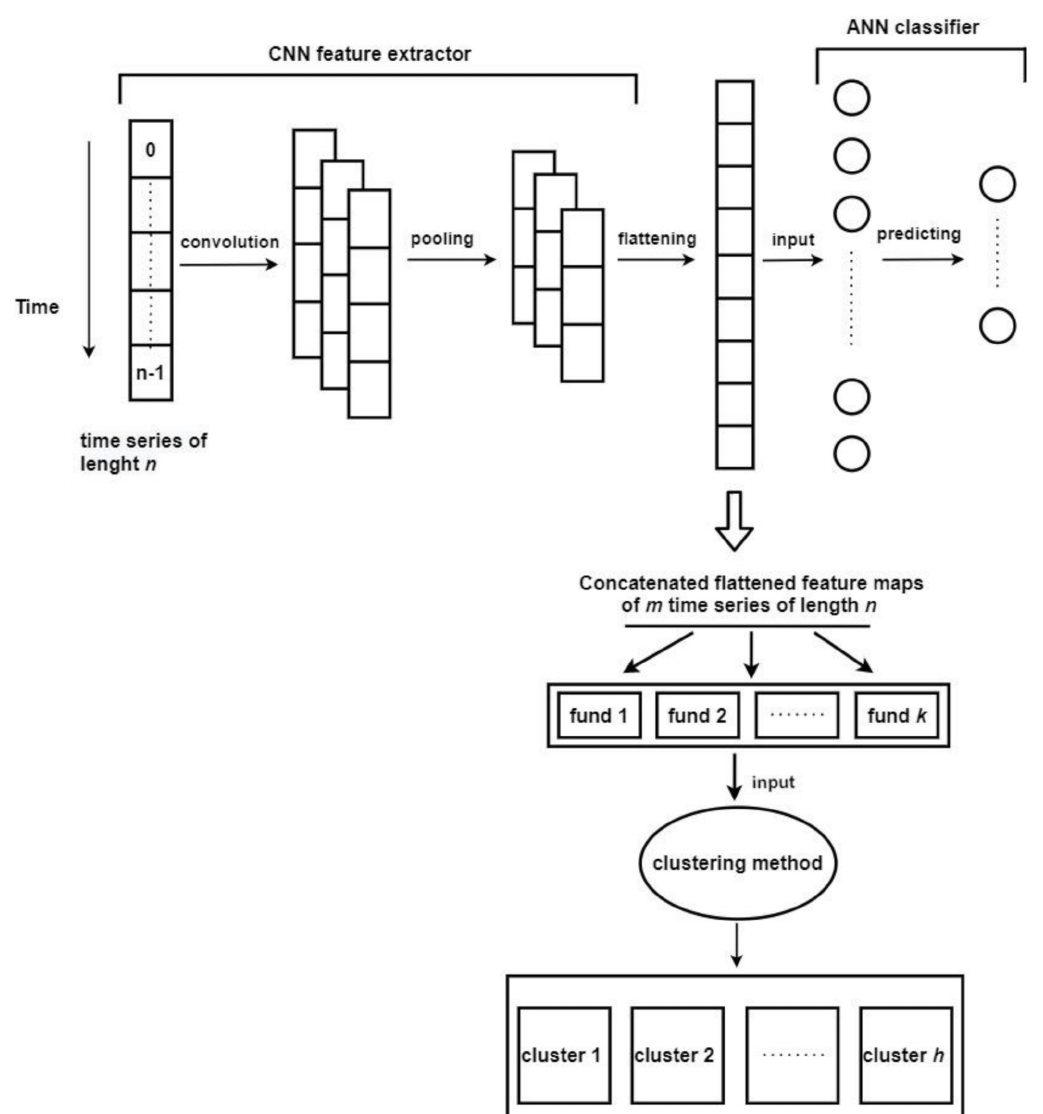
Figure 1. Scheme of CNN application for preprocessing and clustering